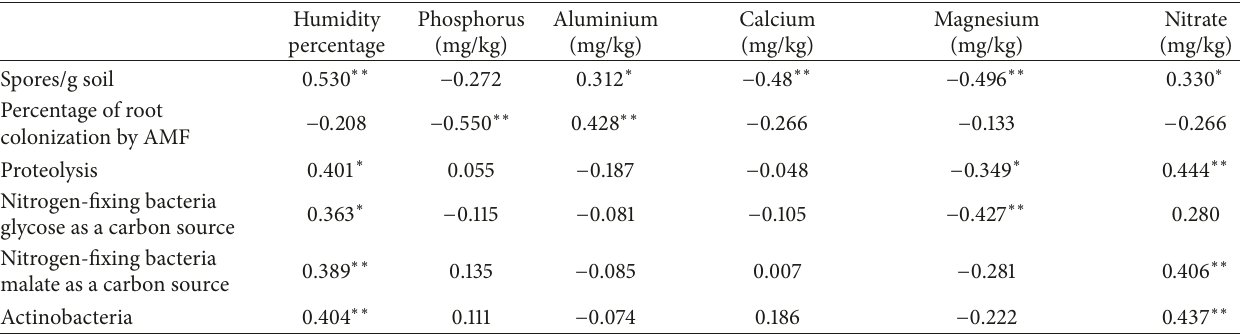
Table 1: Spearman’s correlation (Rho) coefficients between physicochemical properties, microorganism, and biological activity of endomycorrhizal fungi in the soil from 48 farms in the North and Magdalena Medio subregions in Antioquia,